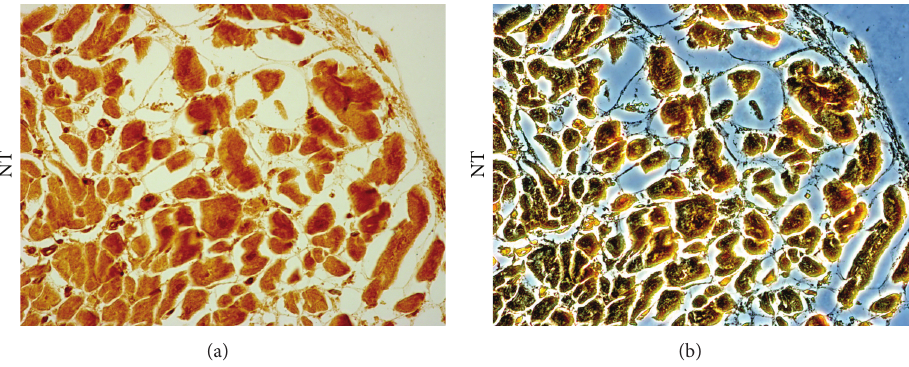
Figure 3: Nitrotyrosine (NT) expression in the cardiac tissue of patient died following sepsis. Bright field (a) and contrast phase (b) microscopy image of cardiac sample of a septic patient, showing a strong immunopositivity to anti-nitrotyrosine antibody (Abcam, Cambridge, UK). Personal observation of a 60-year-old man diagnosed with acute suppurative cholangitis and treated with antibiotic therapy and endoscopic drainage. Jaundice slightly improved; however, on the third day after admission, an echocardiography showed biventricular wall dysfunction. The patient died on third day despite massive fluid and vasopressor support.